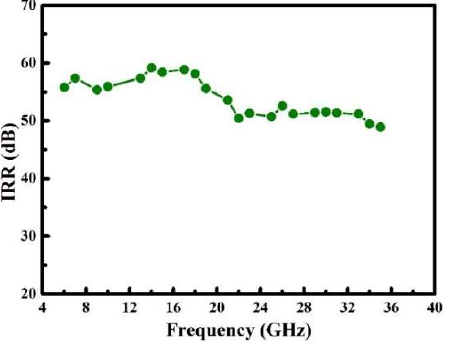
Figure 8. Image rejection ratios (IRRs) of the mixer under various input RF signals at different fre- quencies.